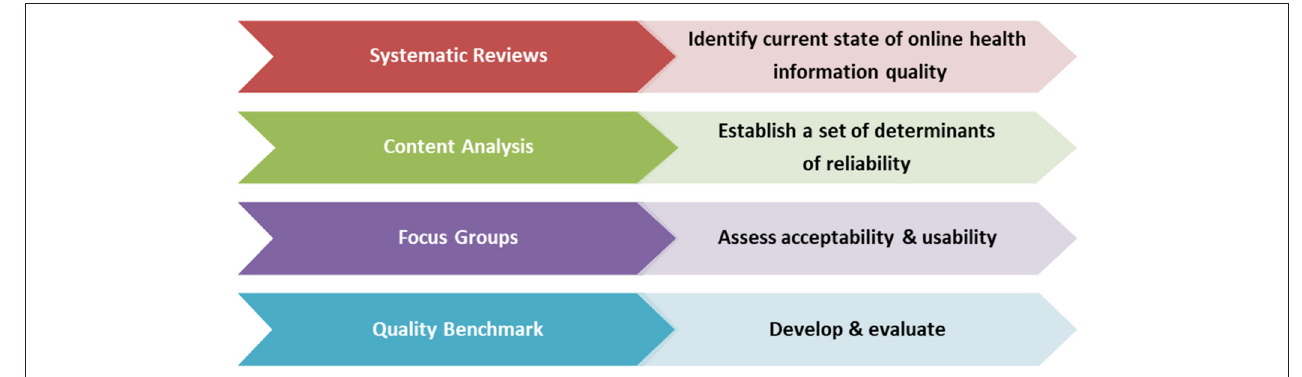
FIGURE 1 | Methods to develop quality benchmarks for use by patients and